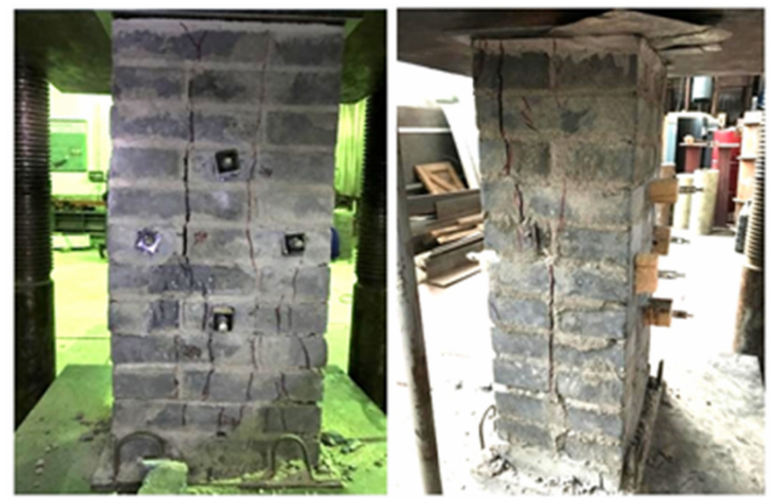
Figure 4. Failure of the autoclaved fly-ash-brick